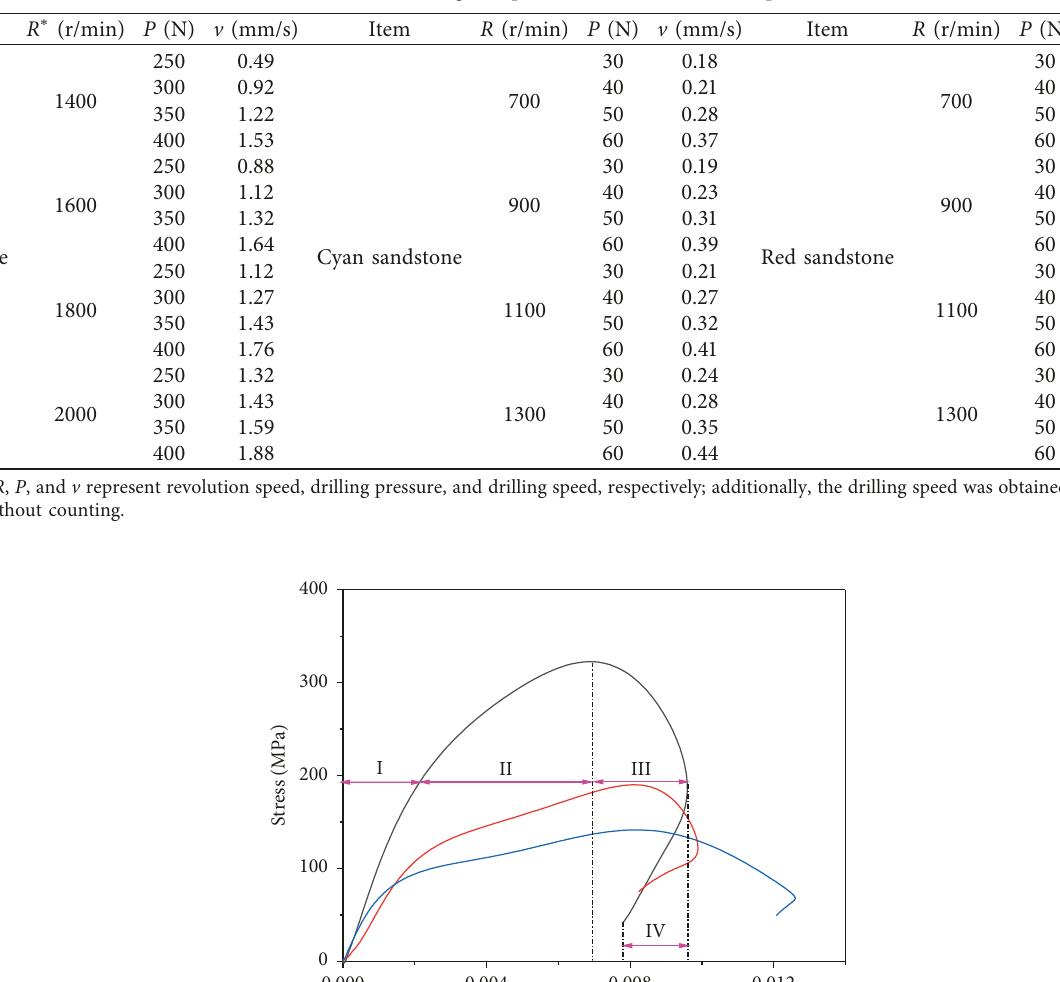
Table 3: Drilling test parameters of different samples.